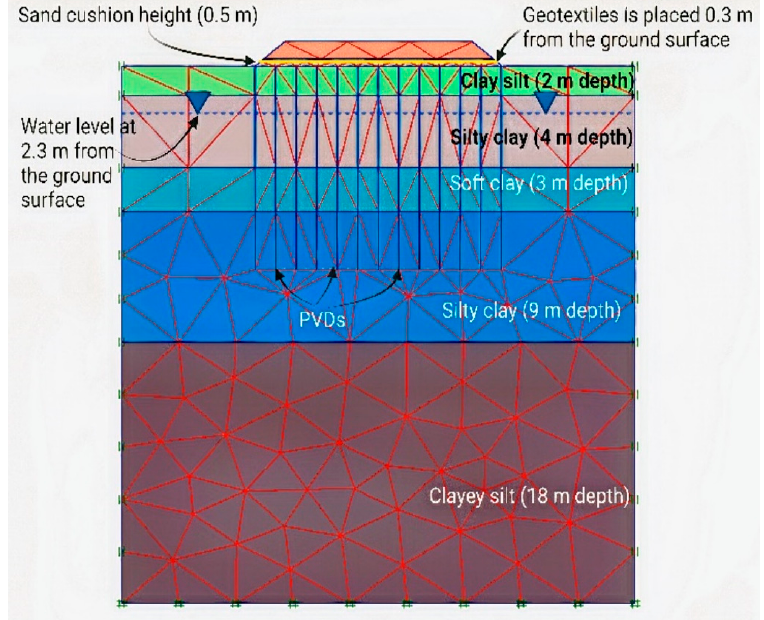
Figure 4. Finite element model with mesh structure.